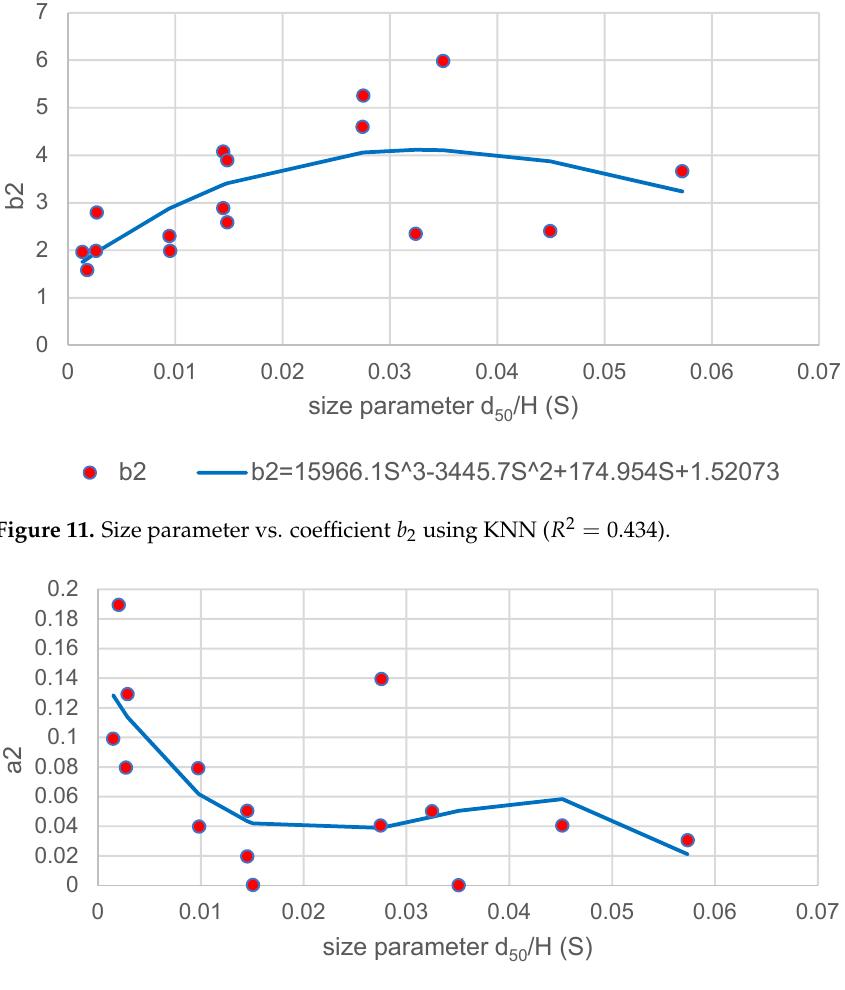
Figure 10. Size parameter vs. coefficient 𝑎 (cid:2869) using decision trees ( 𝑅 (cid:2870) = 0.4313 ).